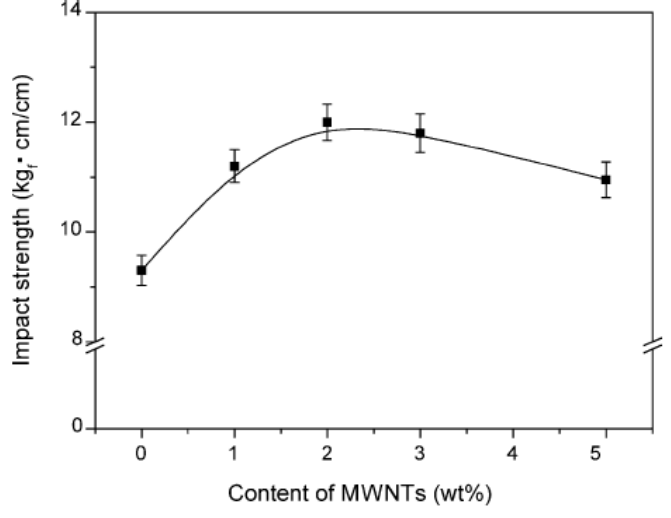
Figure 10. Impact strength of MWCNTs/PP composites as a function of MWNTs content. Reproduced with permission from ref.